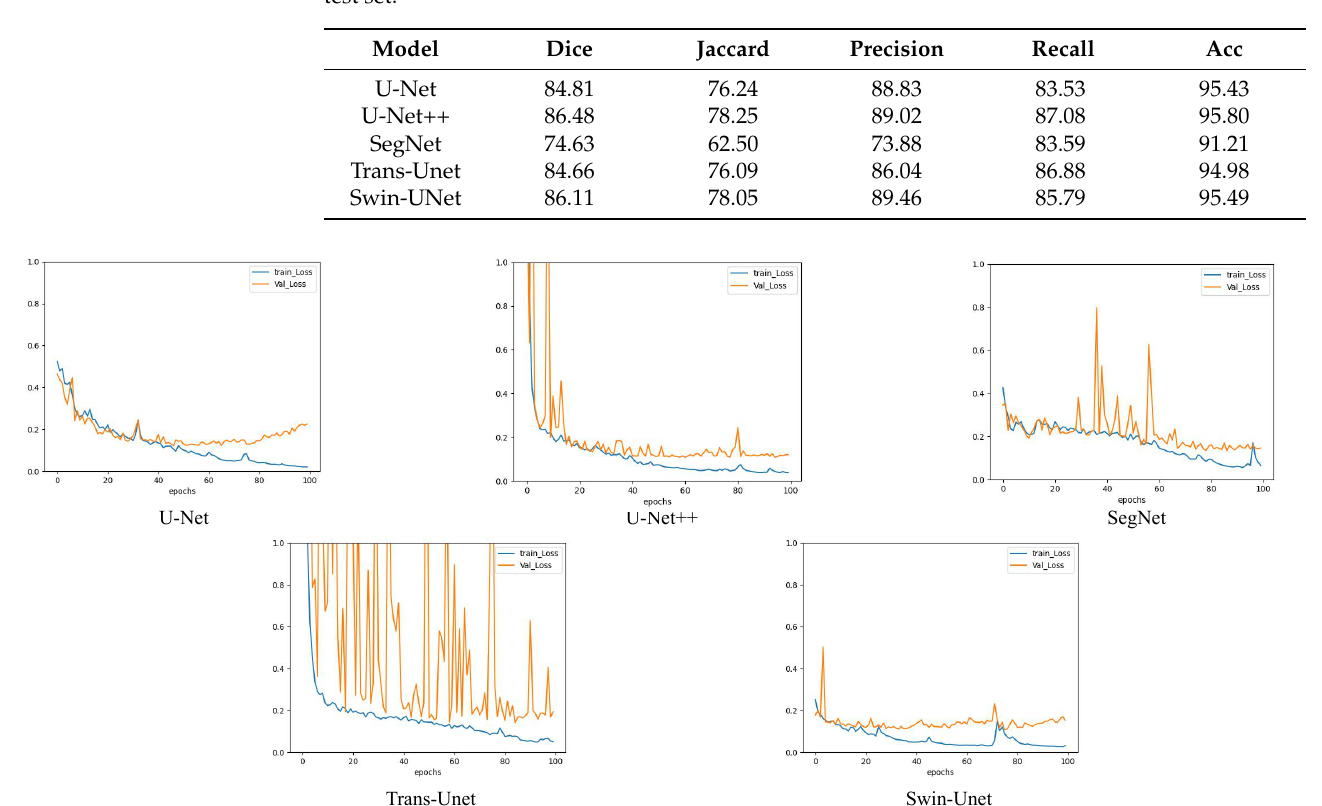
Table 7. Segmentation performance of models of five-fold cross-validation experiment on the EMDS-6 test set.